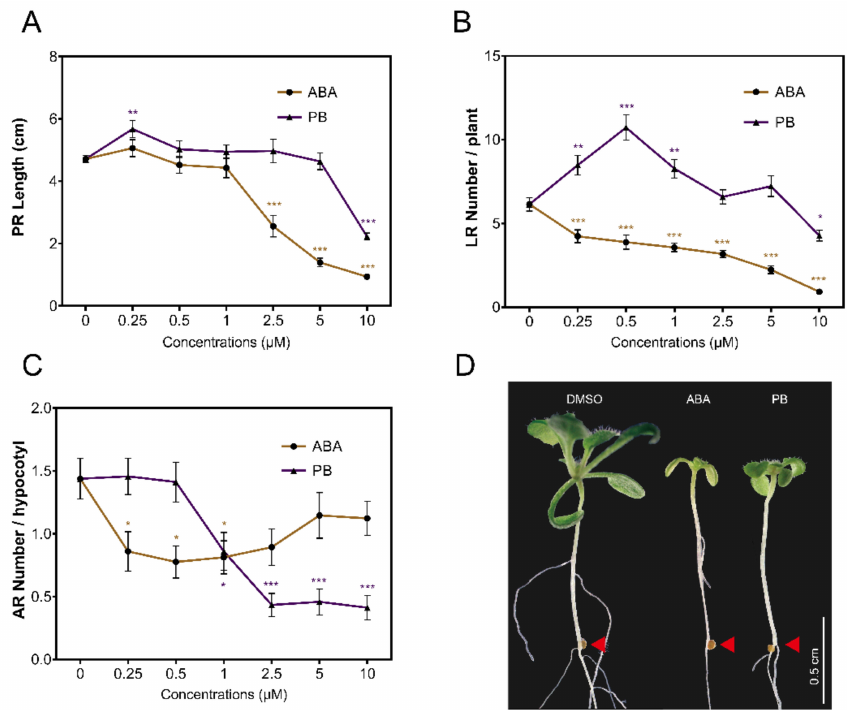
Figure 1. In vitro root development in response to exogenous application of ABA and PB. ( A – C ) ABA and PB dose–response curves of primary root growth ( A ), lateral root number per plant ( B ) and adventitious root number per hypocotyl ( C ). ABA and PB was applied at concentrations from 0 µ M to 10 µ M. ( D ) Adventitious root phenotype of Col-0 plants in the absence or presence of 10 µ M ABA and PB; photographs were taken 10 days after de-etiolation; the red triangle points to the hypocotyl root junction. Bar = 0.5 cm. Data are represented as mean values ± se and were obtained from plants grown in three independent experiments ( n = 20–25). Statistics were calculated through ANOVA and levels of significance are represented as (*) p ≤ 0.05, (**) p ≤ 0.01, (***) p ≤